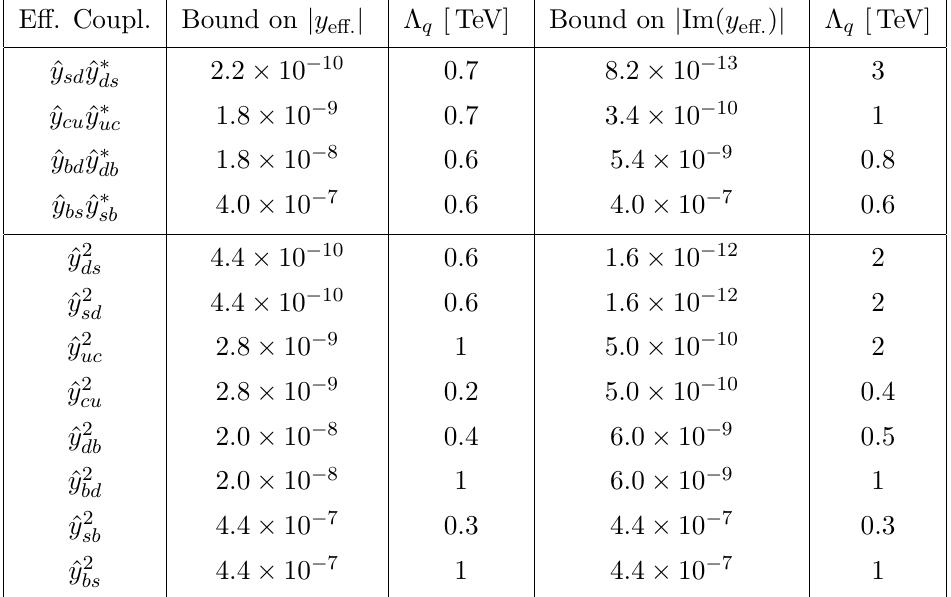
FN lower bounds on the NP cut-off scale Λ q in TeV following from the off-diagonal effective Yukawa couplings in the quark sector. The bounds in the first half of the table are independent of the FN charges, and the others are obtained taking (cid:15) = 0 . 23 and with the charge assignments given in table 1. The bounds are extracted from ref. [77]. The FN O (1) coefficients are taken equal to